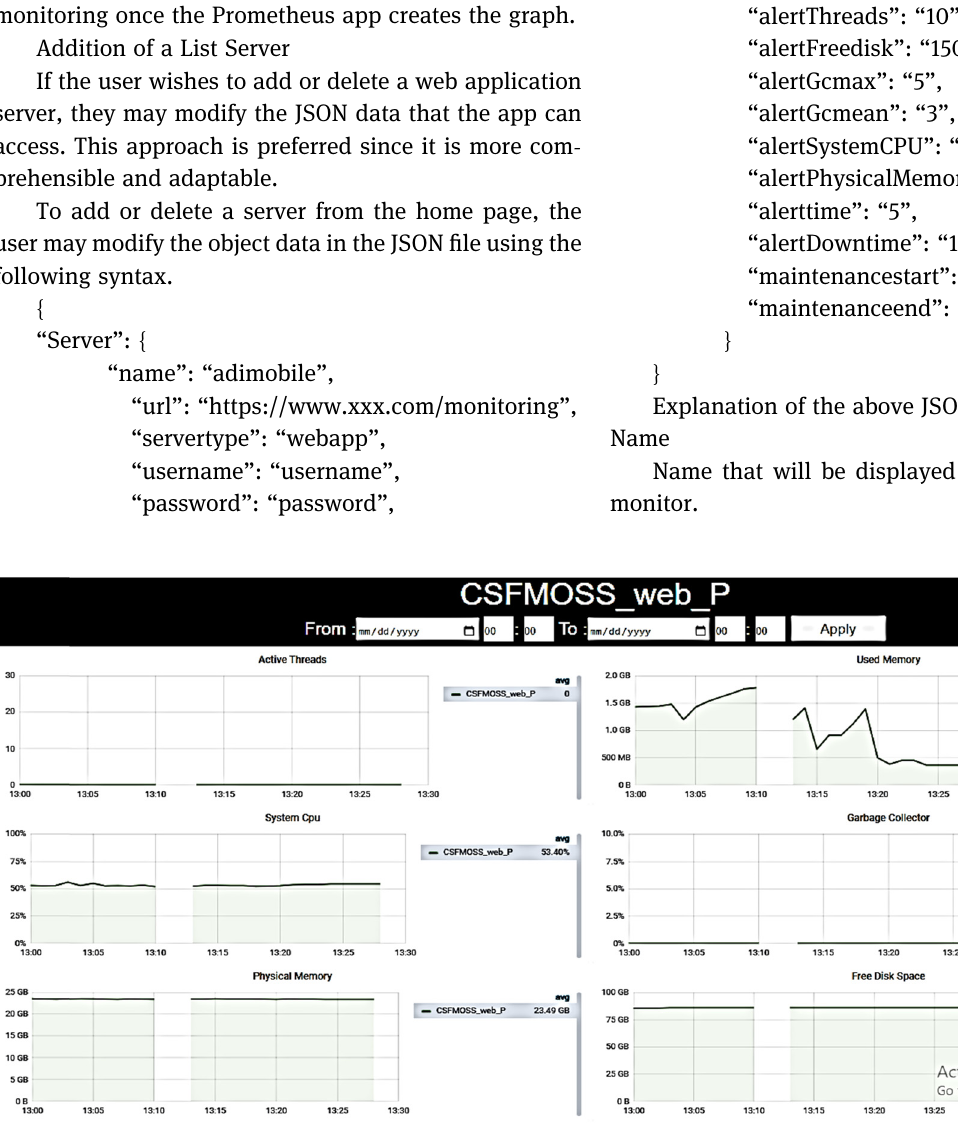
Figure 6: Server details page with a range of 30